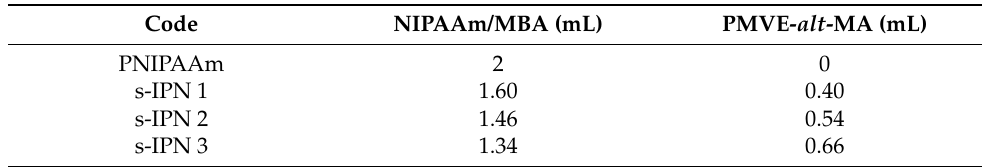
Table 1. Feed solution volumes in the preparation of hydrogels.